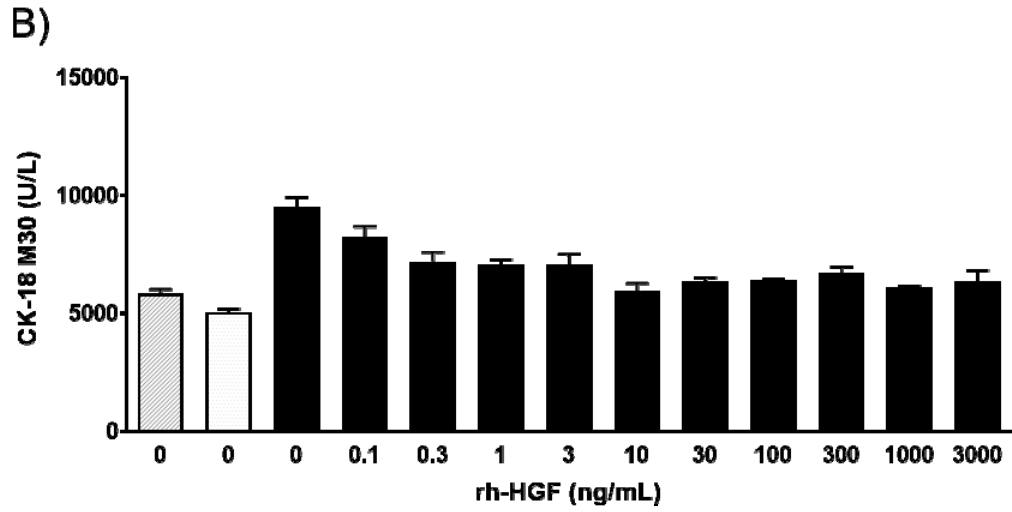
Figure 1. Effects of recombinant human hepatocyte growth factor (rh-HGF) in a Fas antibody-induced human hepatocyte injury model. ( A ) Caspase-3/7 activity, ( B ) CK-18 M30 fragment concentration. Each bar represents the mean ± SEM of representative hepatocytes cultured in triplicate. None, no antibody; Isotype, mouse Immunoglobulin G3 (IgG3) isotype control antibody; anti-Fas, anti-human Fas monoclonal antibody.